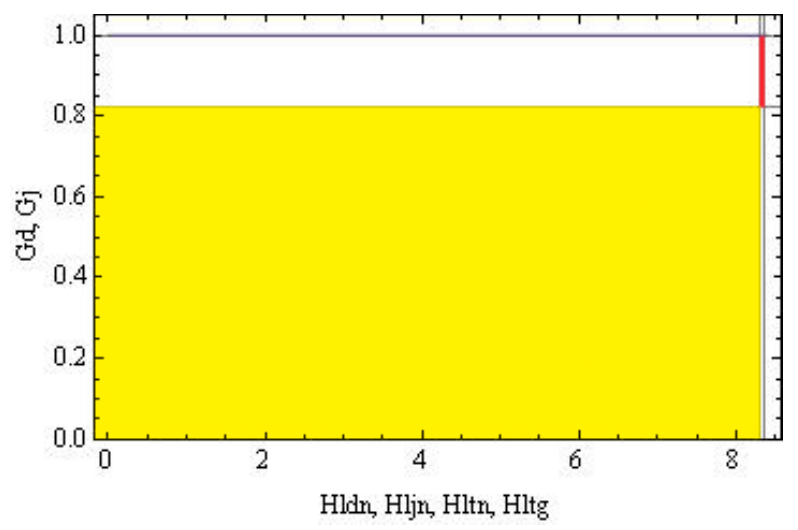
Figure 7. Characterization of a representative intradisciplinary and intertopical orthodox PH. Black area (0%) = networking; red area (0.1%) = intradisciplinary and intratopical heterodox; yellow area (81.9%) = intradisciplinary and intertopical orthodox; blue area (0%) = interdisciplinary and intertopical orthodox. G d = 0, G j = 0.82, H ldn = 8.19, H ljn = 8.33, H ltn = 8.34, H ltg = 8.34. Abbreviations: G d , Gini index for disciplines; G j , Gini index for journals; H , Hirsch indexes; d = discipline, g = gross, j = journal, l = linear, n = net, t = total.